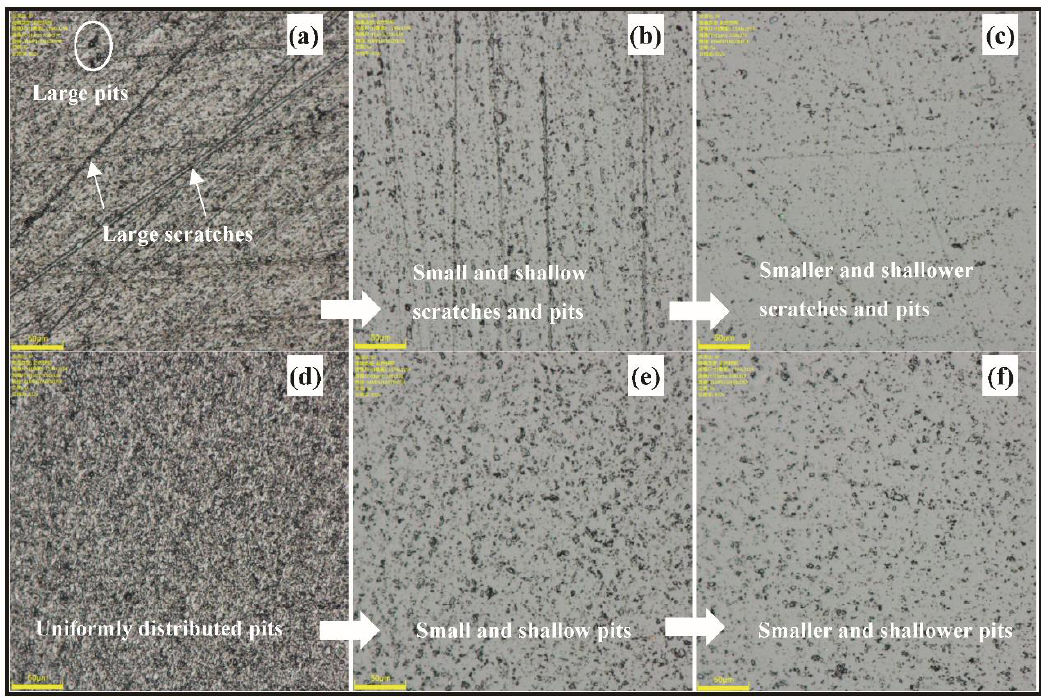
Figure 5. Microscope images (832 × ) of Si-face SiC processed by the designed comparative experiments: ( a ) conventional lapping; ( b ) conventional CMP after conventional lapping(C-c); ( c ) ultrasonic CMP after conventional lapping (C-u); ( d ) ultrasonic lapping; ( e ) conventional CMP after ultrasonic lapping (U-c); ( f ) ultrasonic CMP after ultrasonic lapping (U-u).